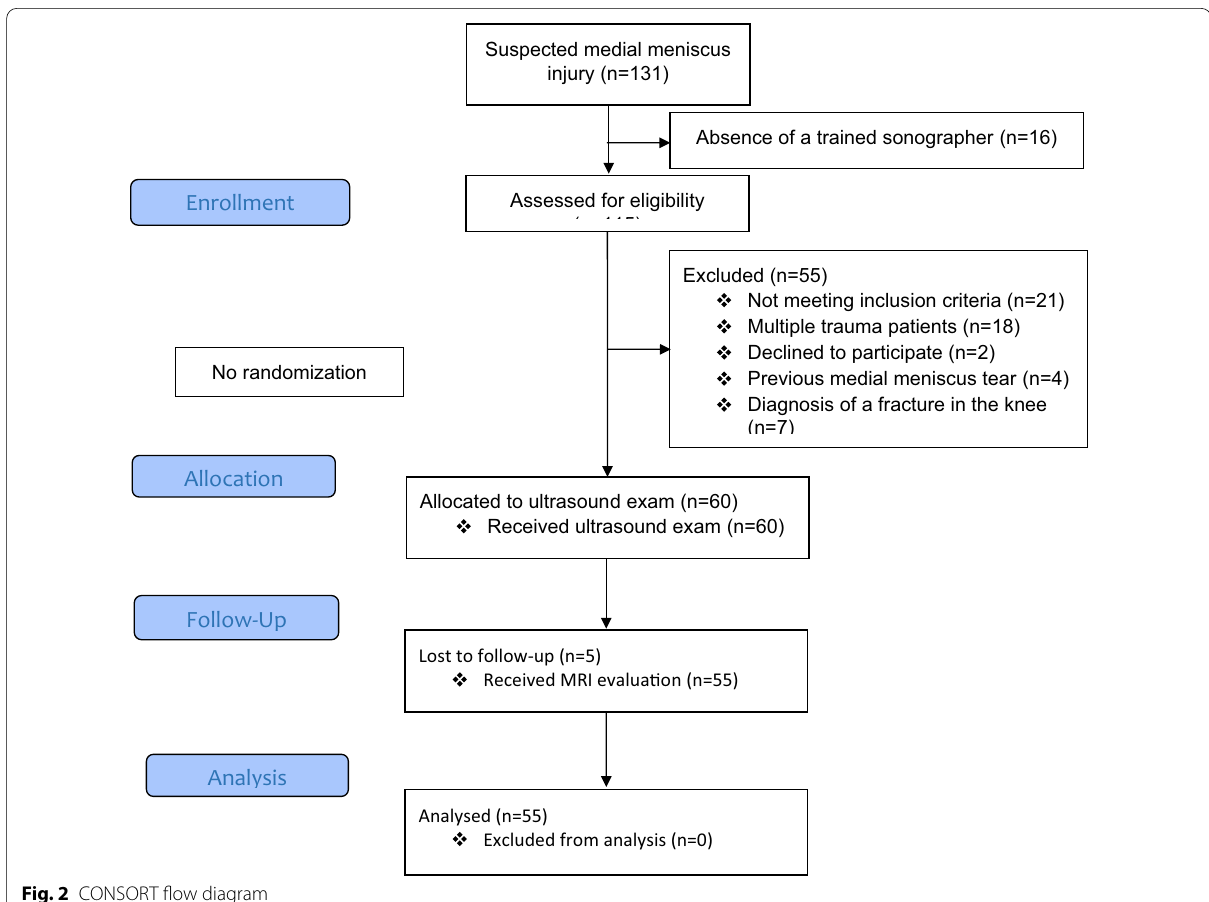
Fig. 2 CONSORT flow diagram